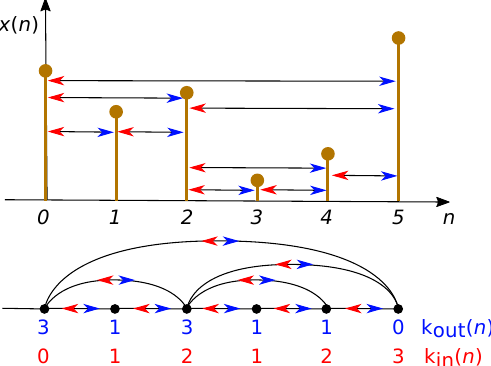
Figure 3. Illustration of the way the horizontal visibility graph is obtained for a time series x ( n ) according to the criteria in